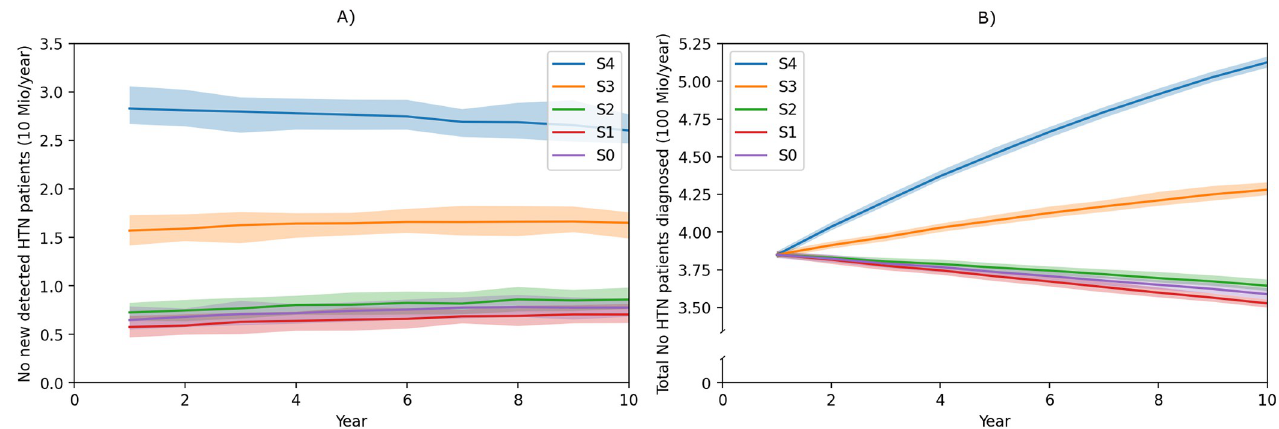
Fig 2. ( A ) Absolute numbers of new detected persons with HTN and ( B ) total number of detected persons with HTN for the different scenarios in LMICs; S0: Base case, S1: Lower accuracy, S2: Improved accuracy, S3: Increased coverage, S4: Increased coverage and screens completed. The bold line represents the mean value and the band the 95% credible interval. The years of model adaptation are excluded in the figure. HTN, hypertension; LMIC, low- and middle-income country.